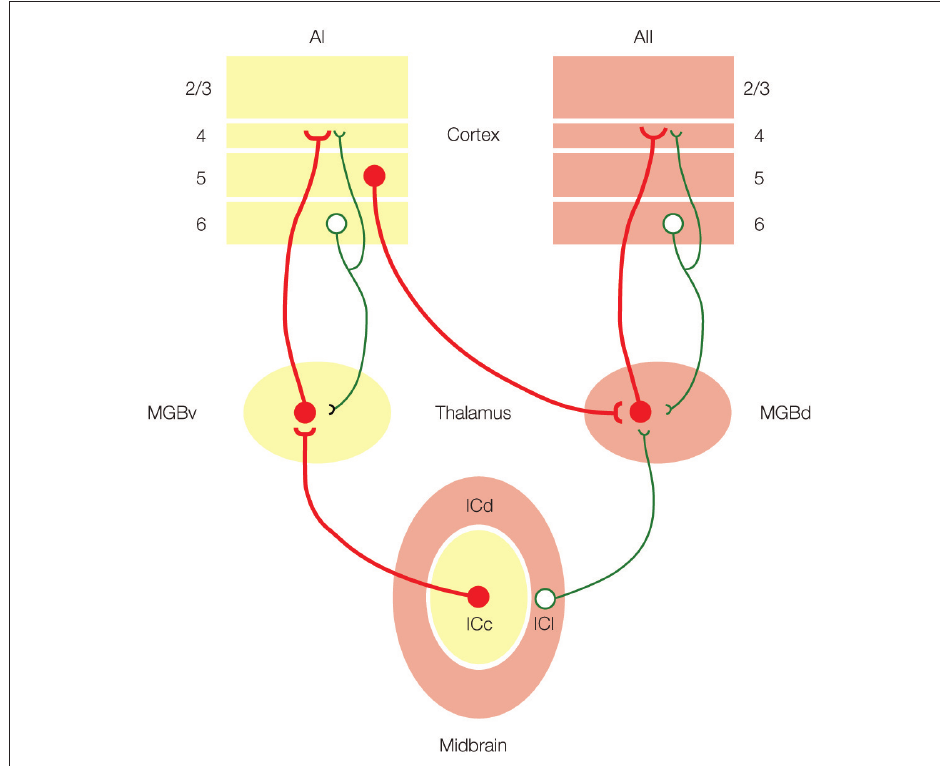
Figure 2 | Model of auditory information flow from the inferior colliculus (IC), medial geniculate body (MGB) and auditory cortex (AI, AII). Driver inputs (red) are the main information-bearing pathways, while modulator inputs (green) modify the information being transmitted (adapted from Lee and Sherman,